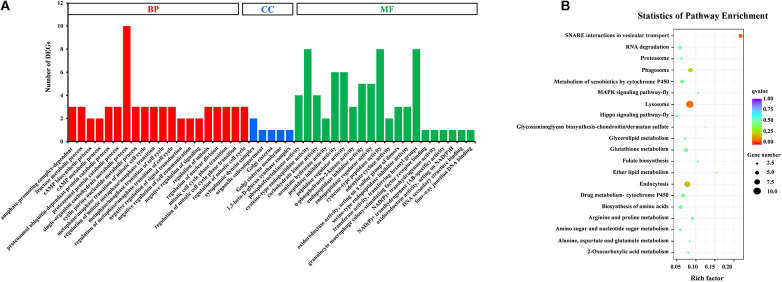
GO classification (A) and KEGG enrichment analysis (B) of DEGs. (A) The results were functionally grouped into three categories: BP (biological process), CC (cellular component), and MF (molecular function). For each categories, the top 20 GO terms were selected for functional analysis. The y-axis indicates the number of DEGs. (B) The top 20 of pathways were functionally analyzed in the KEGG. The X-axis indicates the gene ratio. The Y-axis indicates different pathways.